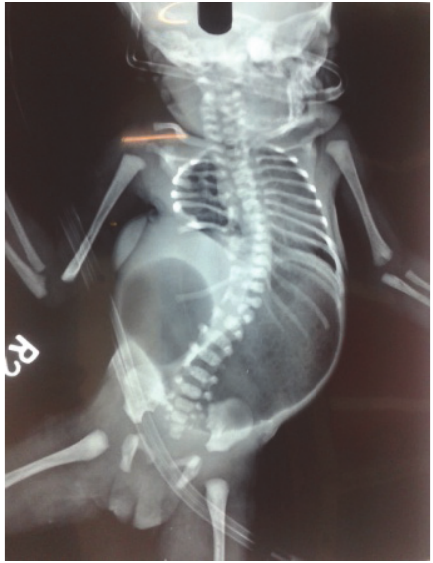
Figure 4: X-ray showing congenital lumbar hernia associated with duodenal atresia and lumbocostovertebral syndrome.